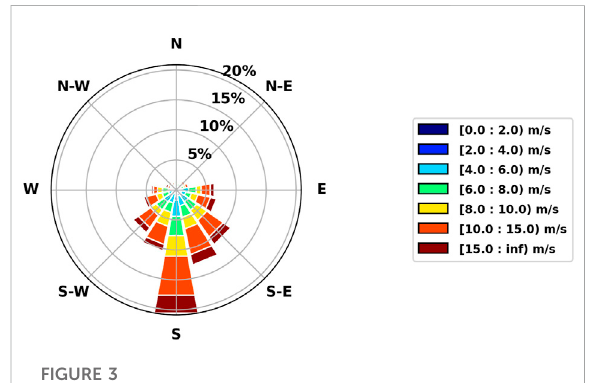
FIGURE 3 Surface wind rose diagrams (%) based on ICOADS observations during NEP fog in winter (1979 –